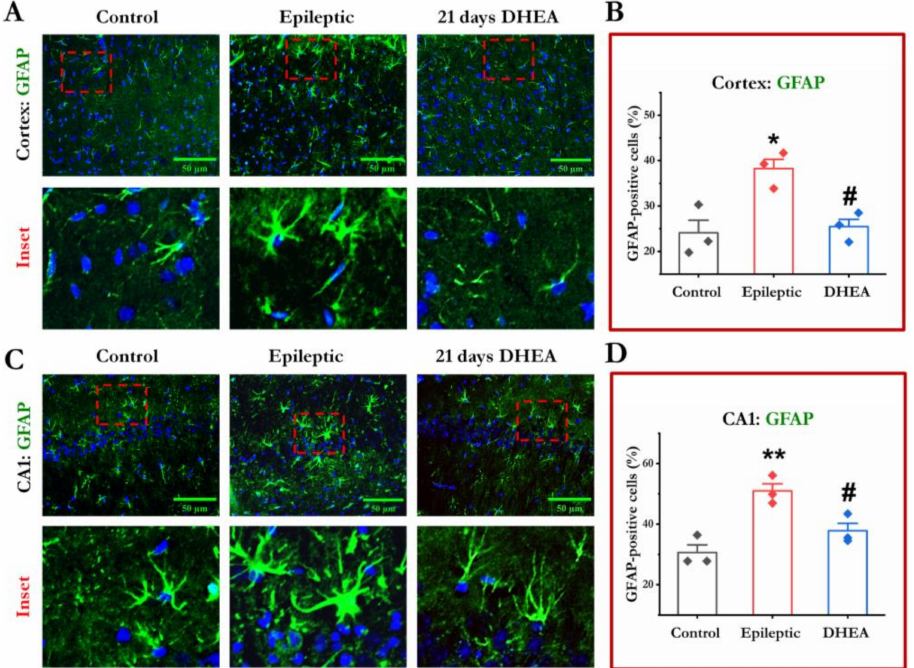
Figure 3. Immunofluorescence analysis of reactive astrocytes in the cortex and hippocampus regions of control, epileptic and DHEA-treated rats. Representative photomicrographs showing GFAP- positive cells (green) ( A , C ). Percentage of GFAP-positive cells in the cortex ( B ) and hippocampus ( D ) of experimental rats. Data are expressed as mean ± SD (n = 3 in each group). * p ≤ 0.05, ** p ≤ 0.01, significantly different from control group; # p ≤ 0.05, significantly different from epileptic group. ANOVA F values for percentage of GFAP-positive cells: cortex 8.356; hippocampus